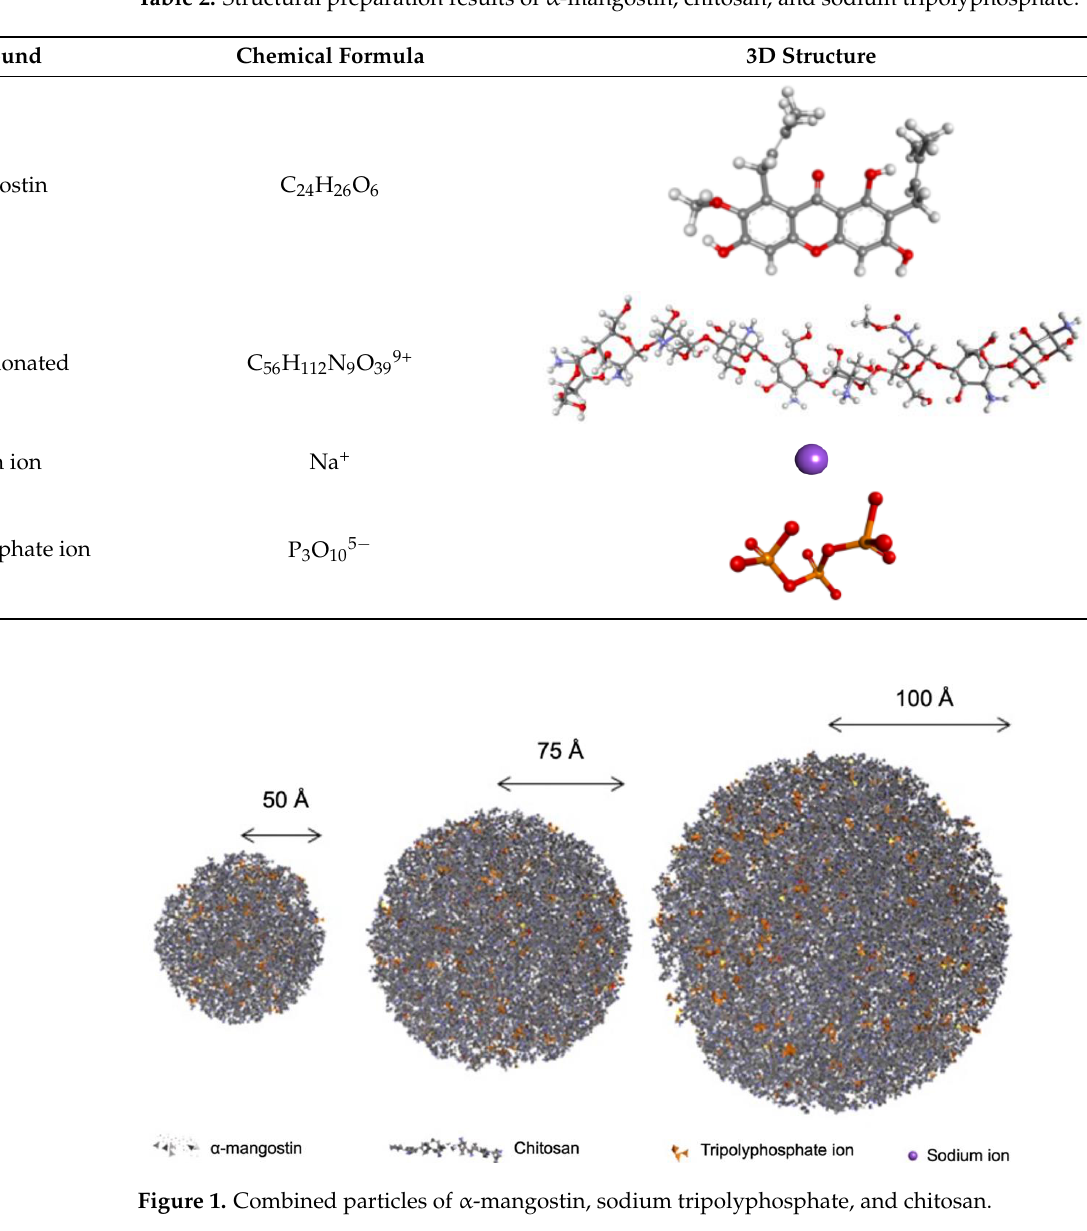
Figure 1. Combined particles of α-mangostin, sodium tripolyphosphate, and chitosan.